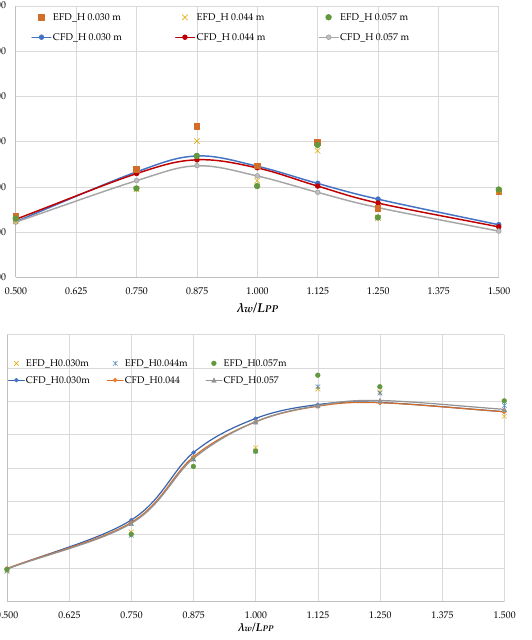
Figure 7. Comparisons of the results for added resistance coefficient: ( a ) 𝐹 𝑅 = 0.131; ( b ) 𝐹 𝑅 = 0.174; ( c ) 𝐹 𝑅 = 0.218.